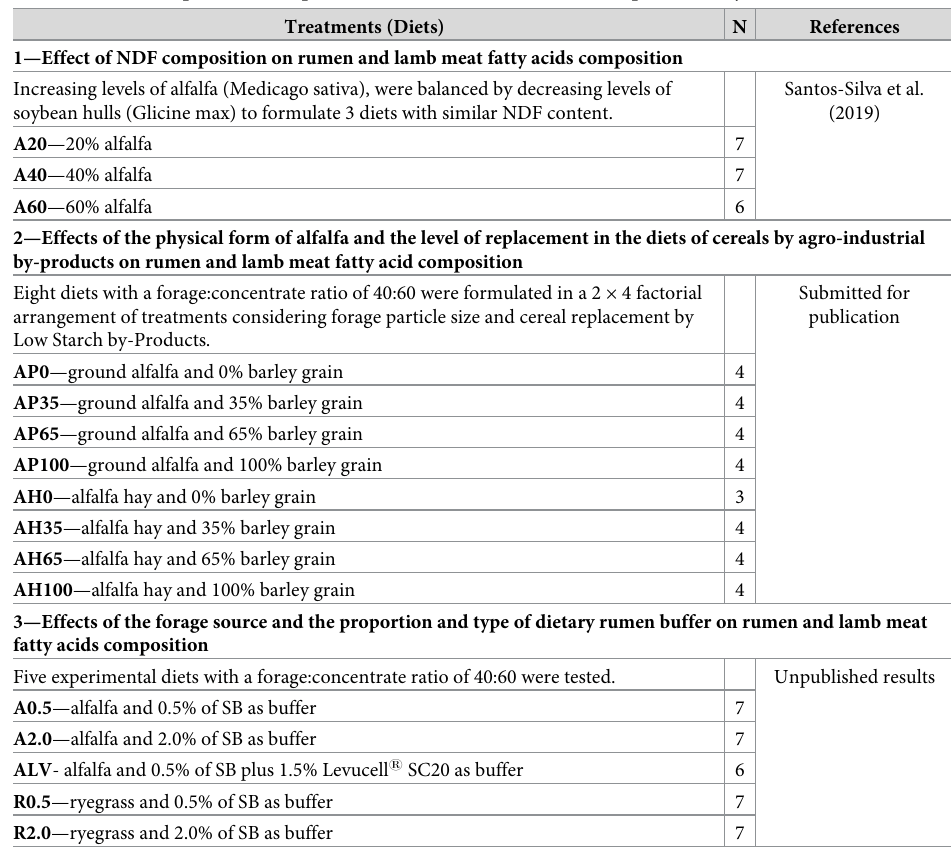
Table 1. Brief description of the experiments whose data were used for the present study. 1—Effect of NDF composition on rumen and lamb meat fatty acids composition Increasing levels of alfalfa (Medicago sativa), were balanced by decreasing levels of soybean hulls (Glicine max) to formulate 3 diets with similar NDF content.